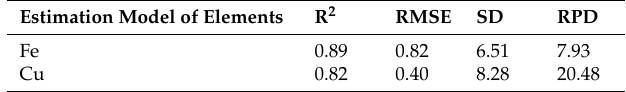
Table 4. The results of Fe and Cu content estimation